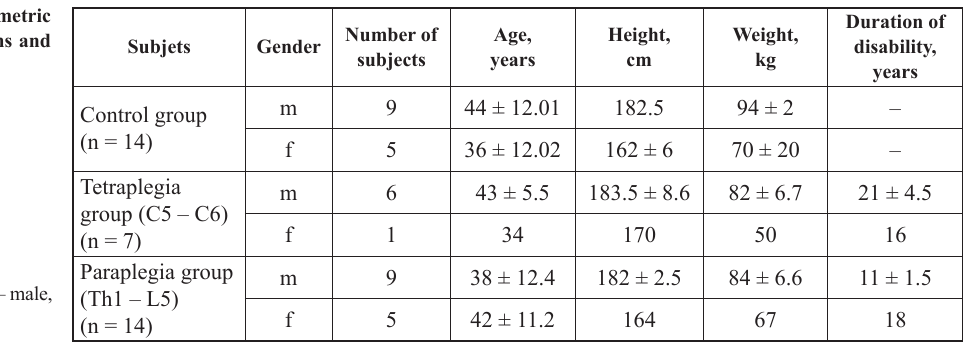
Table 1. Anthropometric data of subjects (means and standard deviations)